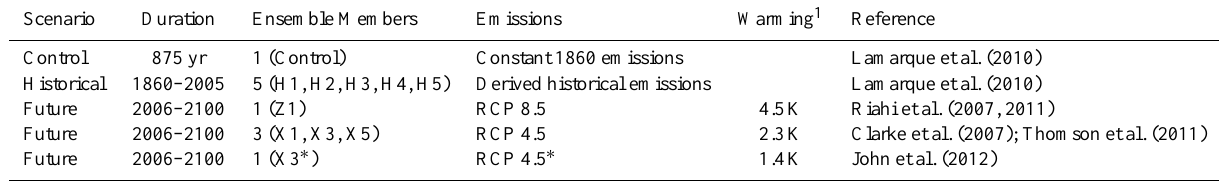
Table 1. Climate and Emission